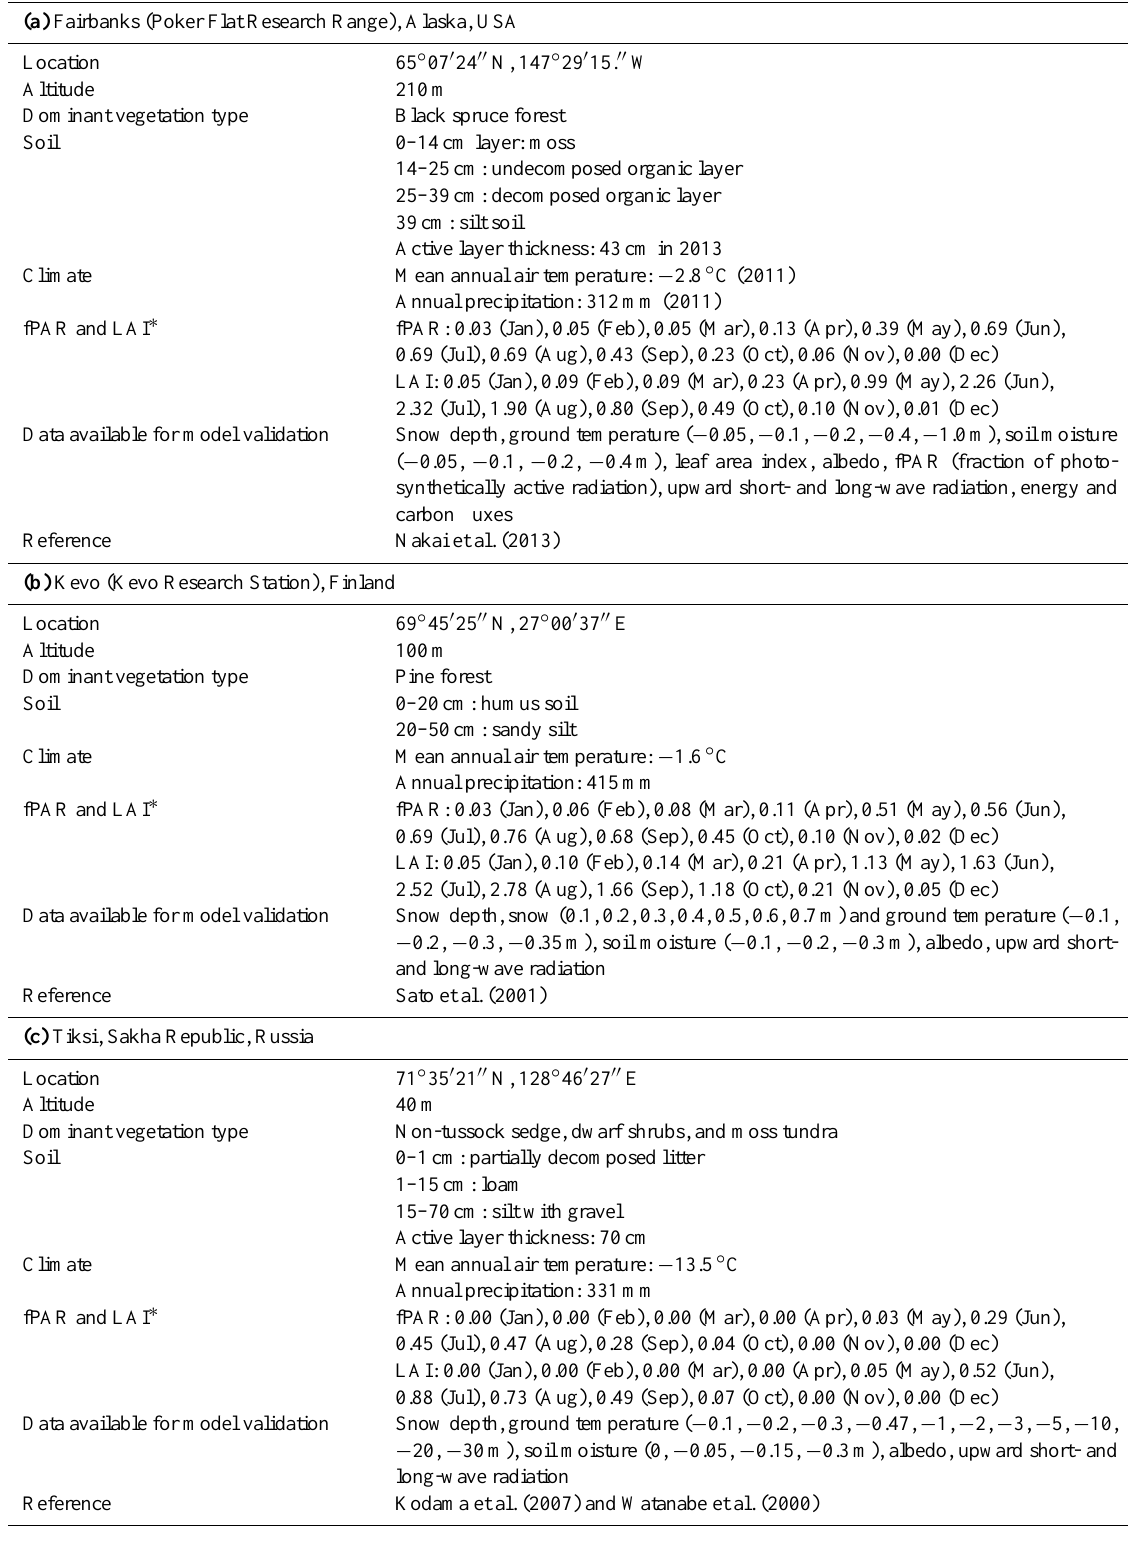
Table 2. The location, dominant vegetation type, soil, climate, fraction of photosynthetically active radiation (fPAR), possible data for validation, and references for observed data for (a) Fairbanks, (b) Kevo, (c) Tiksi, (d) Yakutsk, (e) Chokurdakh, and (f) Tura. (a) Fairbanks (Poker Flat Research Range), Alaska,